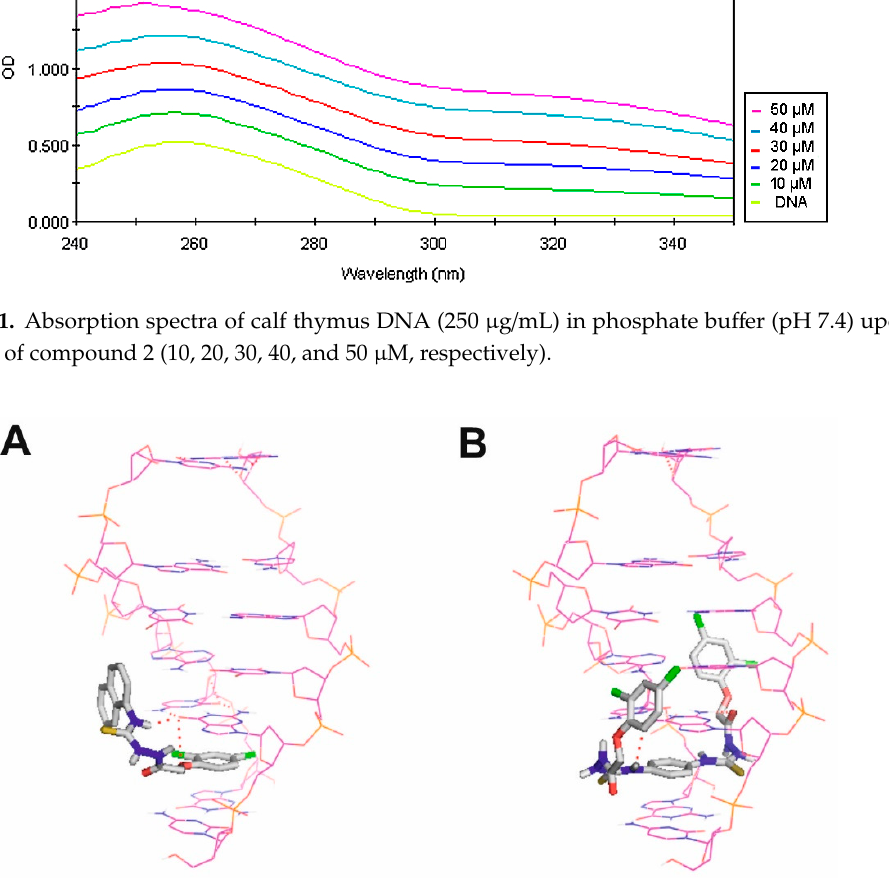
Figure 12. Compound 1 ( A ) and compound 2 ( B ) intercalating with DNA as obtained using molecular docking approach of flexible ligands to rigid DNA fragment. DNA is shown in wire representation with magenta carbon atoms. Ligands are shown in stick representation with grey carbon atoms. Non-polar hydrogen atoms not shown for clarity. Hydrogen bonds are shown as red dashed lines.